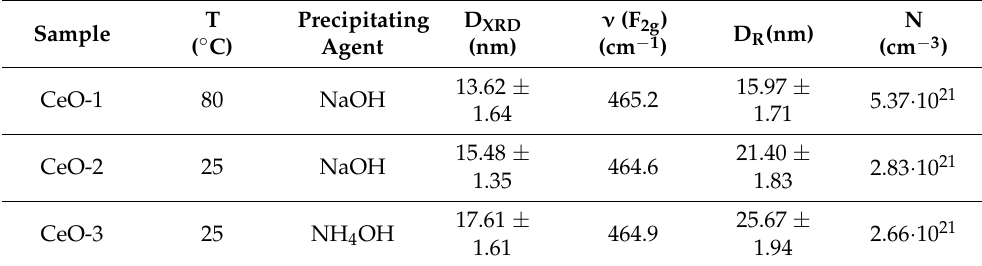
Table 1. Raman and XRD parameters of cerium oxide